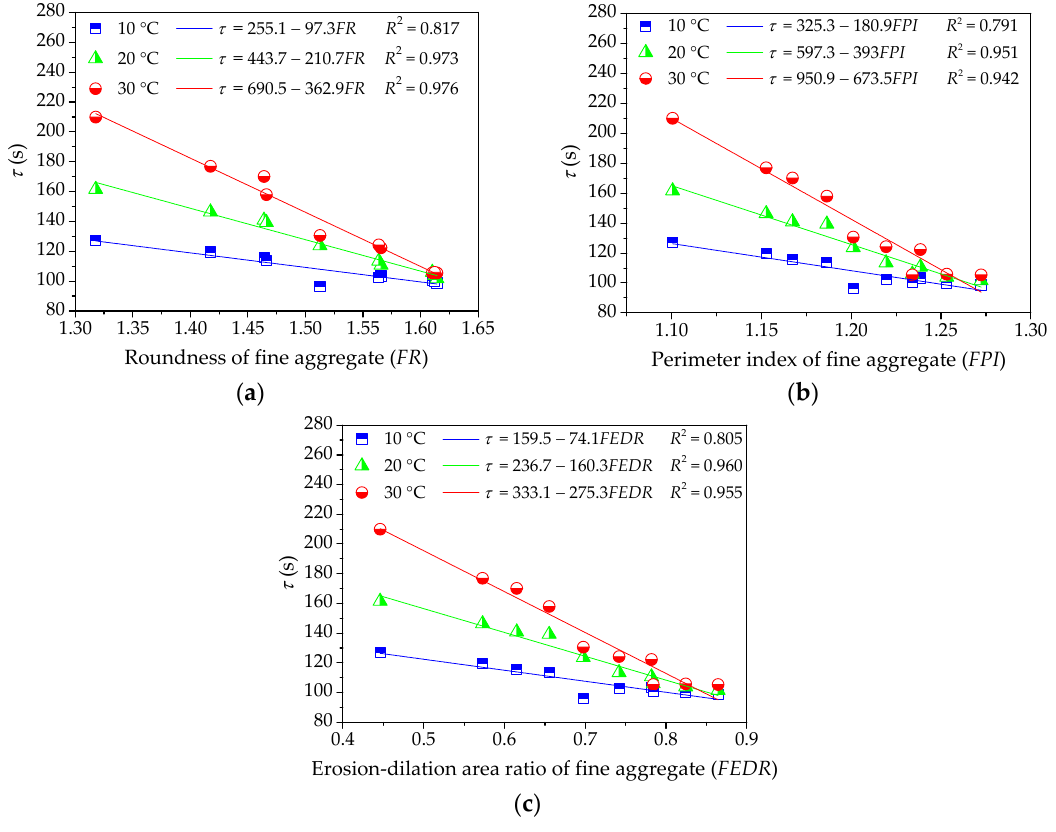
Figure 8. Influences of fine aggregate morphological characteristics of on τ of asphalt mortar: ( a ) Shape ( FR ); ( b ) Angularity ( FPI ); and, ( c ) Texture ( FEDR ).